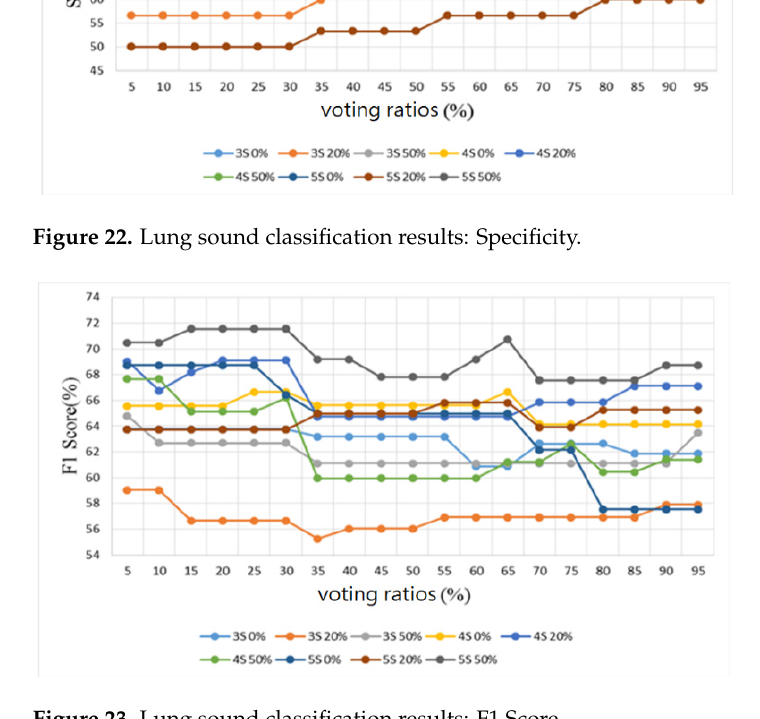
Figure 23. Lung sound classification results: F1 Score.